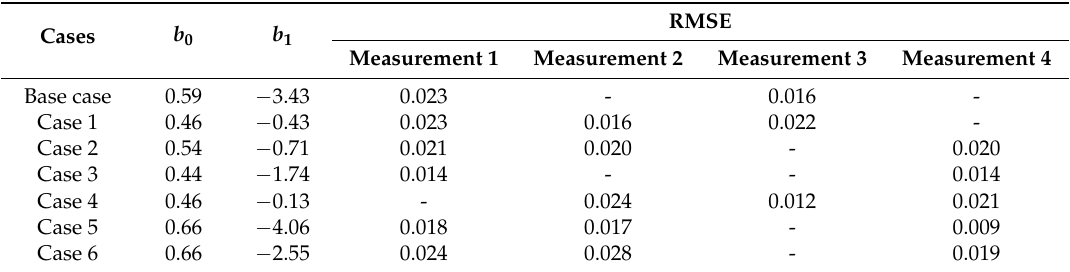
Table 4. Solar collection efficiency characteristics and root-mean-square-error